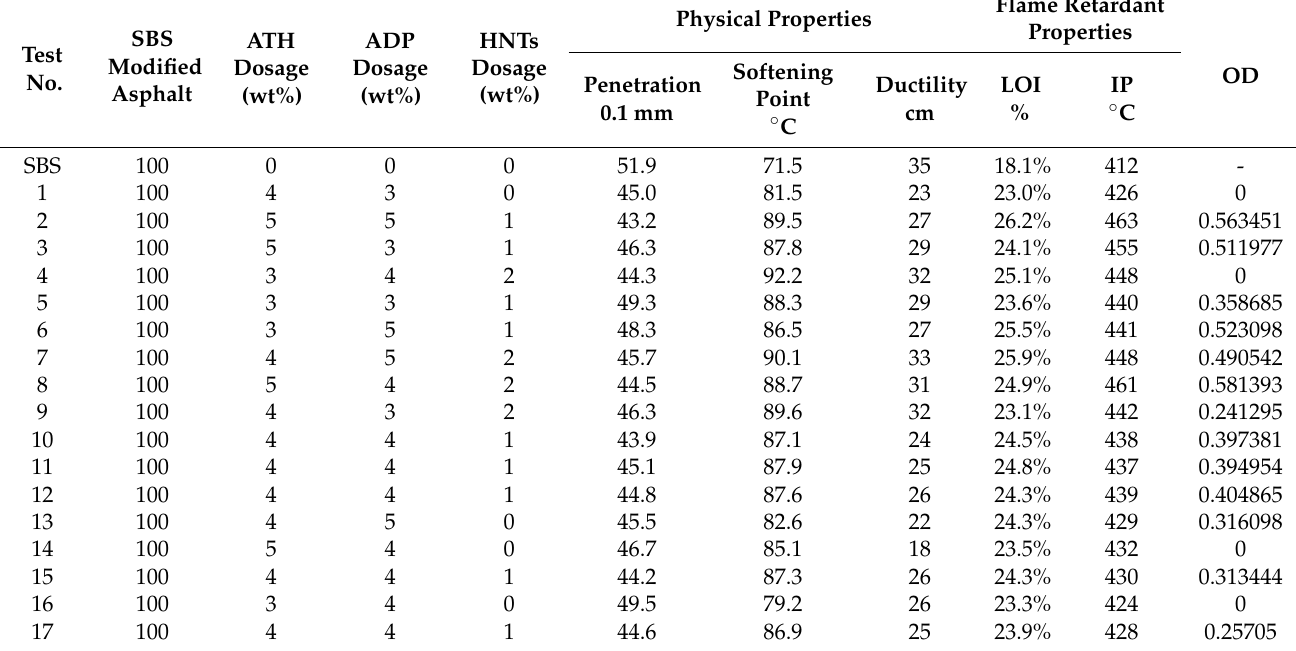
Table 3. Box-Behnken optimized experimental design and